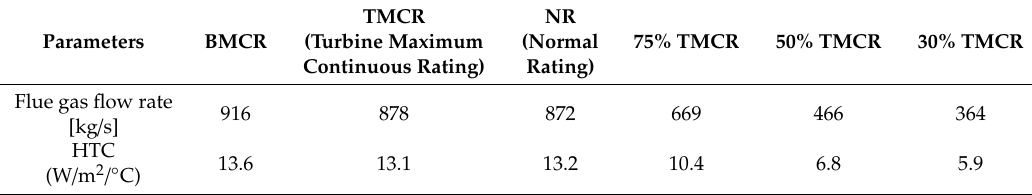
Table 3. Design values of heat transfer coe ffi cient (HTC) for the air preheater (APH) according to the boiler load.